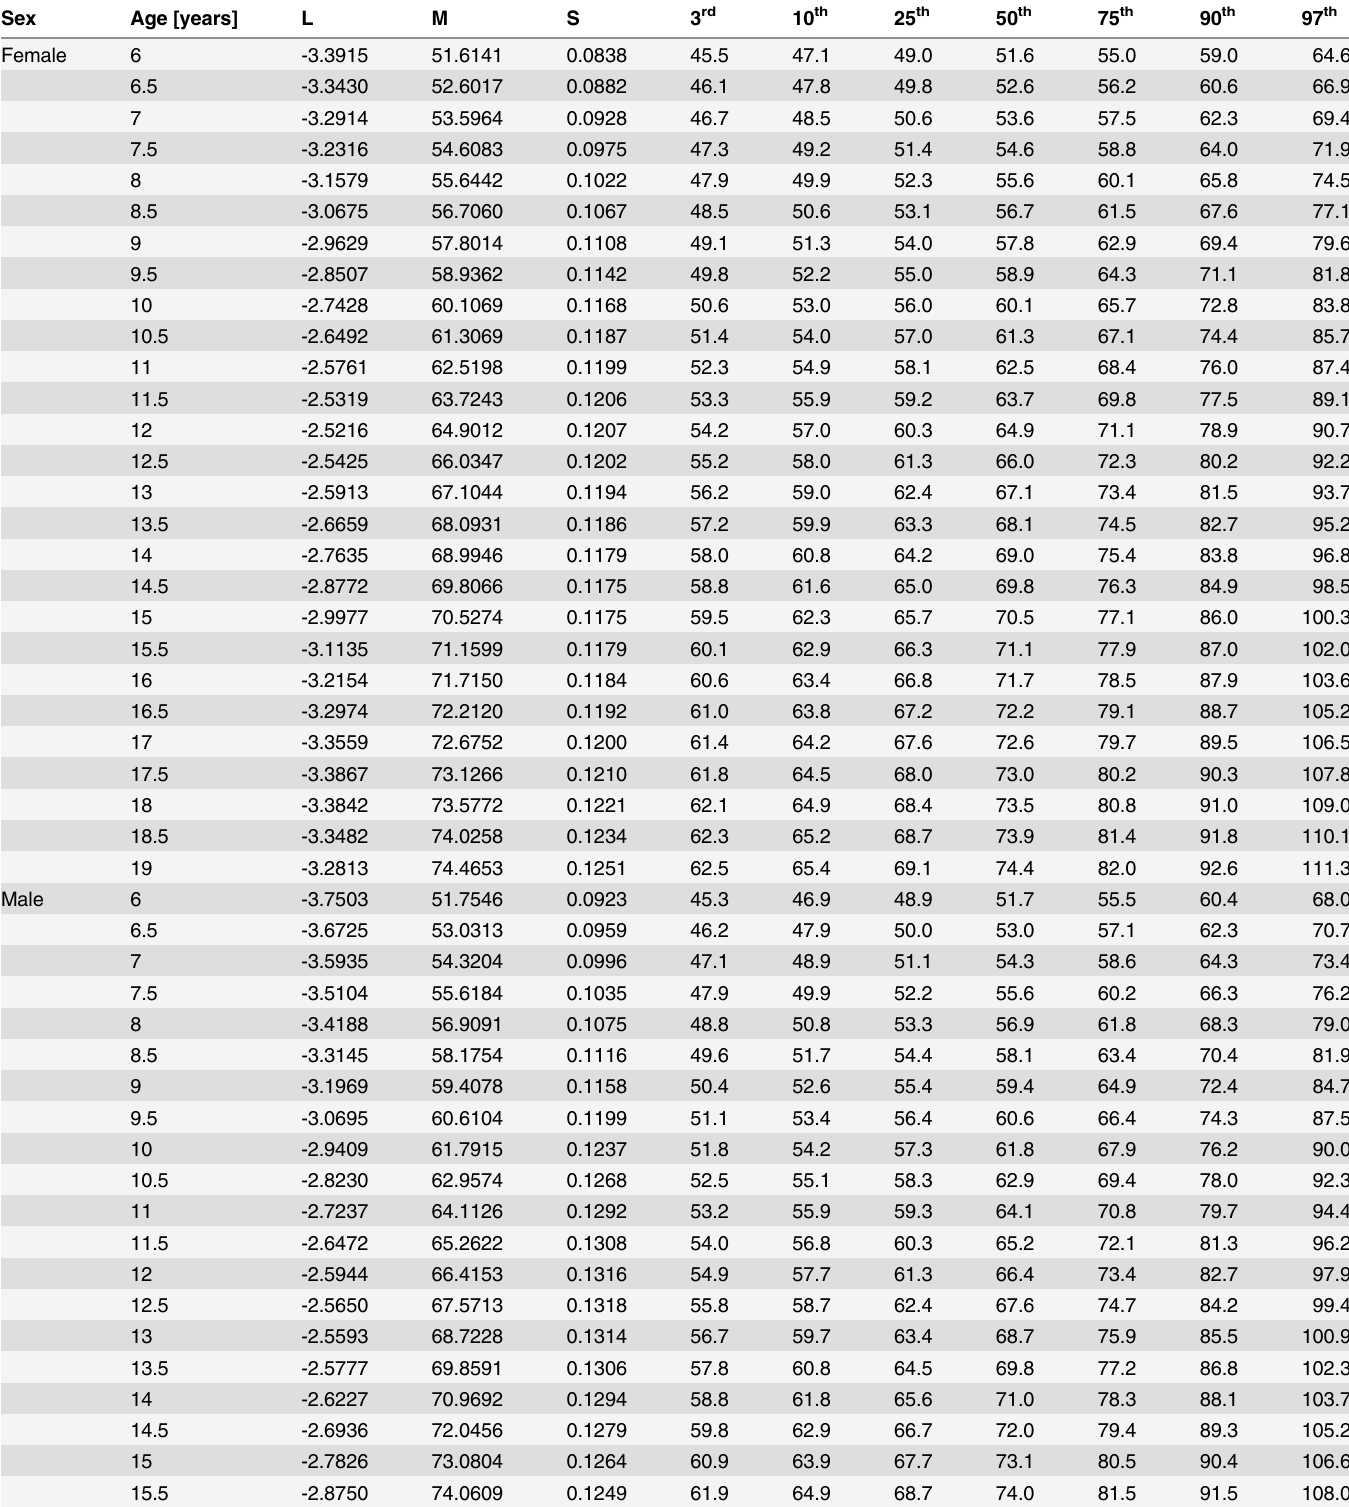
Table 3. L, M, and S values, and percentiles of waist circumference [cm] by age and sex for Canadian children and youth aged 6 to 19